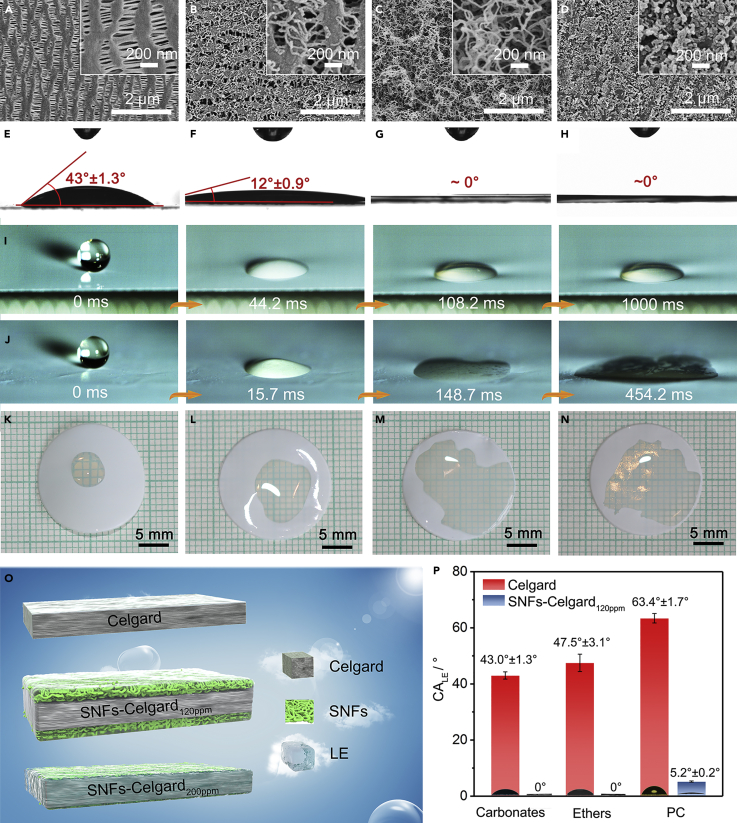
SuperLEphilicity of SNFs-Celgard Separators(A–H) SEM images and CALE images of the (A and E) Celgard, (B and F) SNFs-Celgard50ppm, (C and G) SNFs-Celgard120ppm, and (D and H) SNFs-Celgard200ppm separators.(I and J) Dynamic wetting process of the (I) Celgard and (J) SNFs-Celgard120ppm separators by the LE droplets (6 μL) released from a height of 5 mm. See also Videos S1 and S2.(K–N) Photographs of the LE droplets (10 μL) after they were dropped onto the (K) Celgard, (L) SNFs-Celgard50ppm, (M) SNFs-Celgard120ppm, and (N) SNFs-Celgard200ppm separators for 10 s. See also Figures S7 and S8.(O) Schematic illustrations of the separators with absorbed LE.(P) CALE of the LEs with different surface tensions on the surface of the Celgard and SNFs-Celgard120ppm separators (shown as means ± SD, n = 6). Carbonates: 1 M LiPF6 in 1:1 (v/v) EC and DMC. Ethers: 1 M LiTFSI and 0.2 M LiNO3 in 1:1 (v/v) 1,2-dimethoxyethane and 1,3-dioxacyclopentane. PC: 1 M LiPF6 in propylene carbonate.